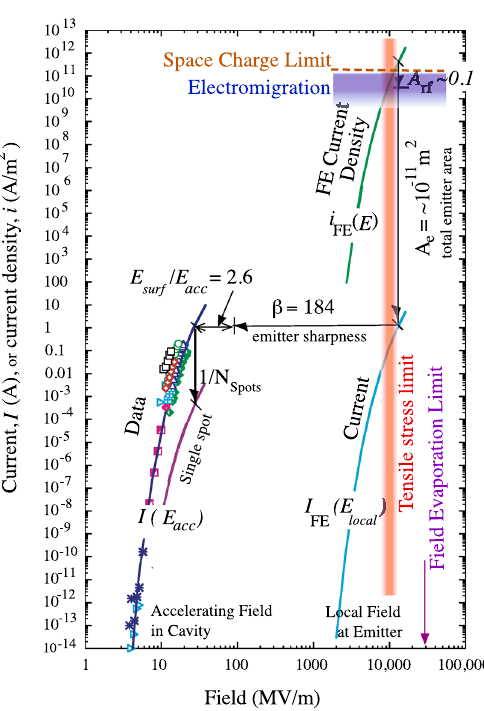
Figure 3. Experimental data of field emission current in a cavity 9 compared with fitted models, showing the magnitude of current density 6 and electric field at the field emission sites, along with the limits that would be imposed by the material tensile strength 9 , electromigration 27 , and field evaporation from smooth surfaces 20 and the space charge limit 18,19 . The experimental data sums the contributions of roughly 1000 emitters 9 . The precise values of the various limits depend on the metallic properties and experimental conditions and the local space charge limit is very difficult to